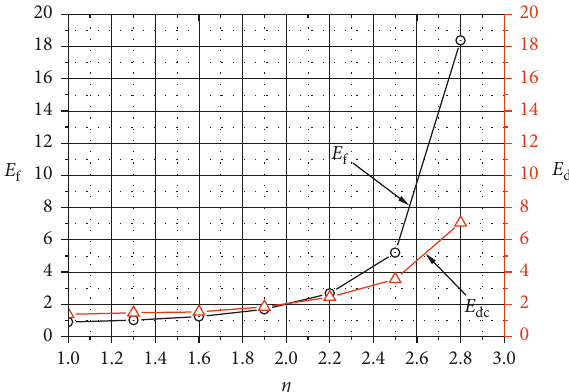
Figure 12: The relation curves for η - E